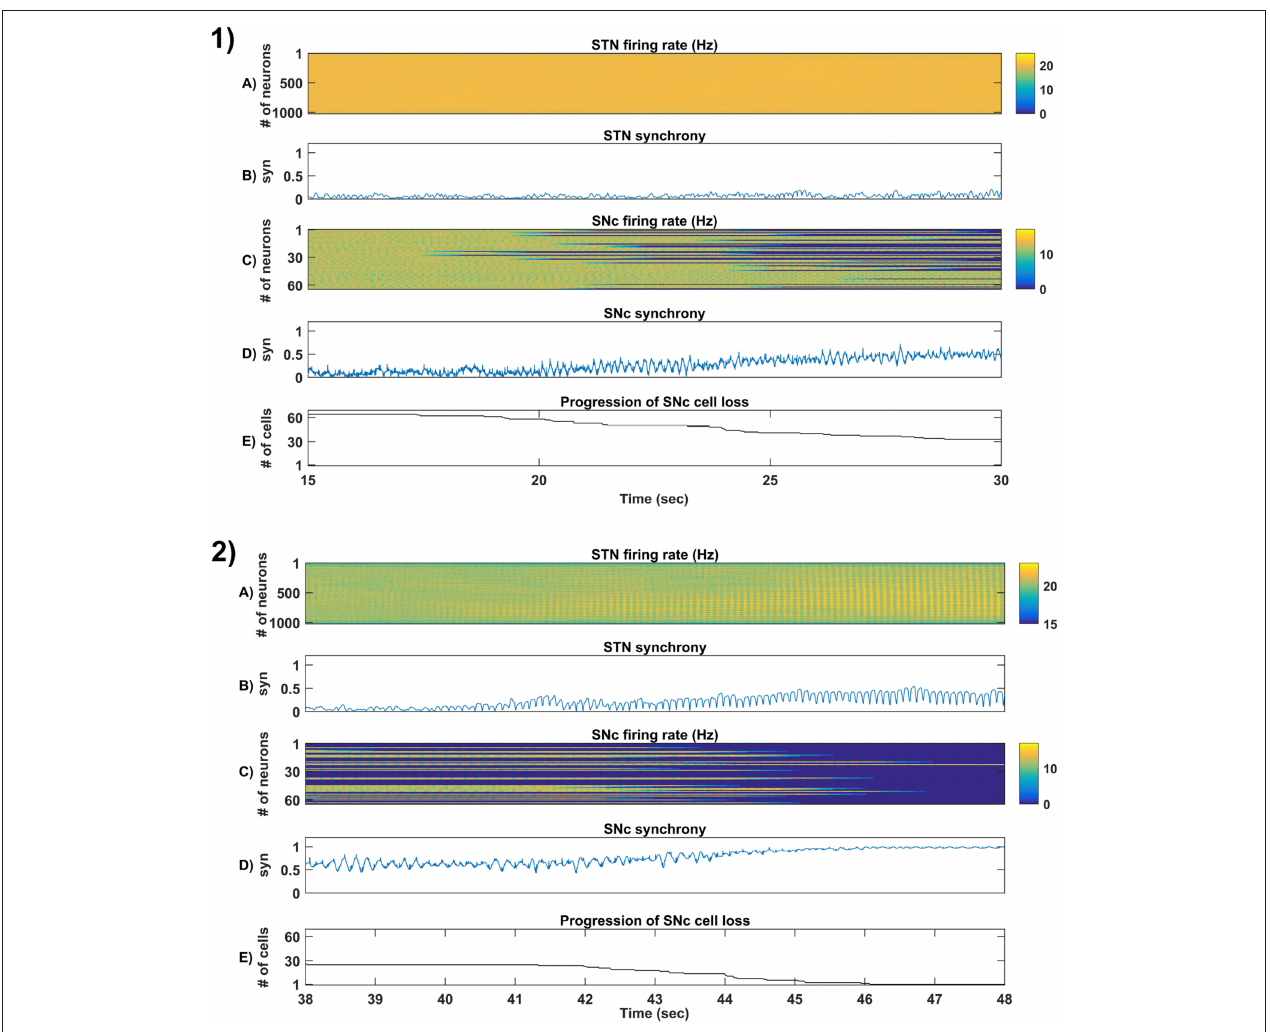
FIGURE 6 | Simulation plots of step-wise mechanisms (II, III) of the proposed excitotoxicity model. (1) Part-II of ( Figure 5-1 ) Stress-induced neurodegeneration in SNc. (2) Part-III of ( Figure 5-1 ) STN-mediated runaway effect of neurodegeneration in SNc - Mean firing rate (1 s) of STN (A) & SNc (C) , Synchrony (syn) of STN (B) & SNc (D) , Progression of SNc cell loss (E) . STN, SubThalamic Nucleus; SNc, Substantia Nigra pars compacta; GPe, Globus Pallidus